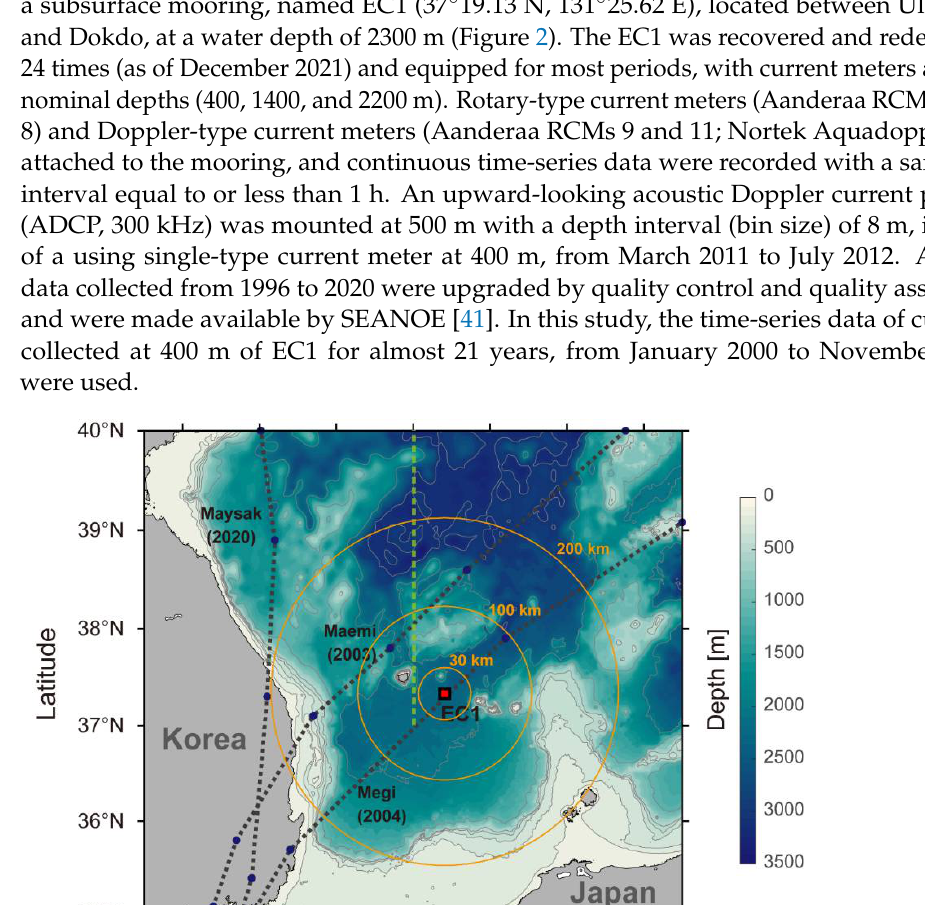
Figure 1. Schematics on interaction between mesoscale flow field (grey line) and wind-induced NIWs (red arrow), enhancing the near-inertial kinetic energy. Red spirals indicate dissipation of NIWs.